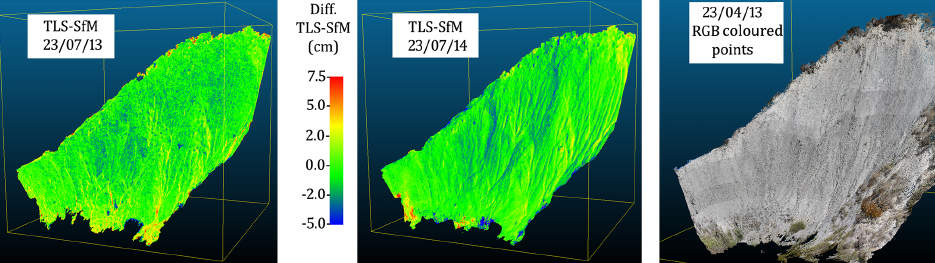
Figure 10. Comparison of DEMs between techniques, considering TLS as the reference, on south-facing slopes. Differences have been calculated for the first and last acquisition dates (23 July 2013 and 23 July 2014) (cloud compare software). A RGB coloured points image is added in the right panel as an overview of the south-facing